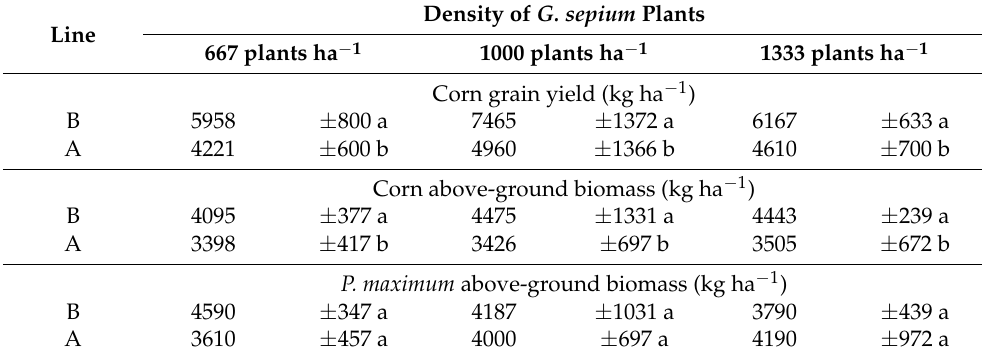
Table 5. Corn grain yield and above-ground biomass of corn and P. maximum cv. Massai from agrisilviculture systems with 667, 1000 and 1333 plants of G. sepium ha − 1 . Corn straws, grains and P. maximum shoots were collected at lines close to the G. sepium plants (A) and in the middle of the plots (B). Density of G. sepium Plants Line 667 plants ha − 1 1000 plants ha − 1 1333 plants ha −